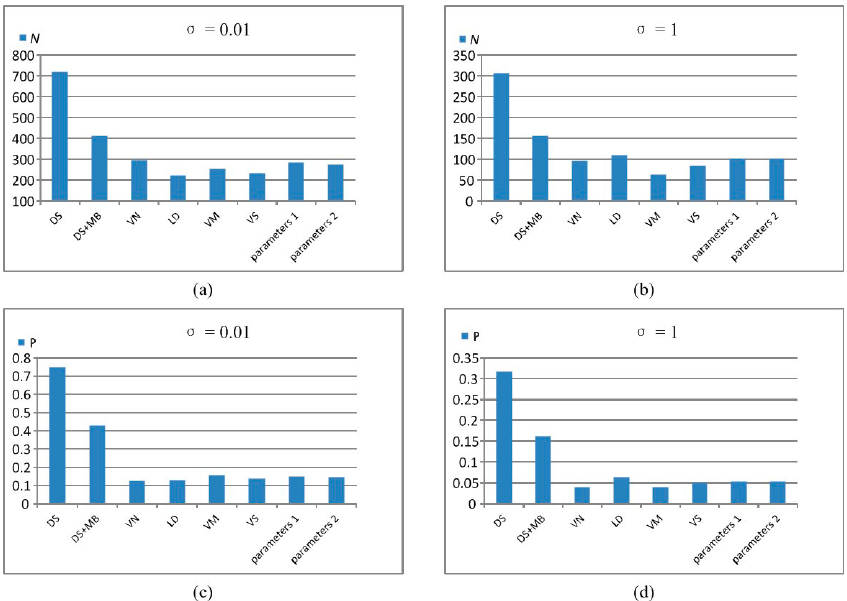
Figure 7. Evaluations of fusion effects of white building pictures in two experiments ( DS (directly seamed); MB (multi-band blending)). ( a ) N with σ = 0.01, ( b ) N with σ = 1, ( c ) P with σ = 0.01, and ( d ) P with σ = 1.